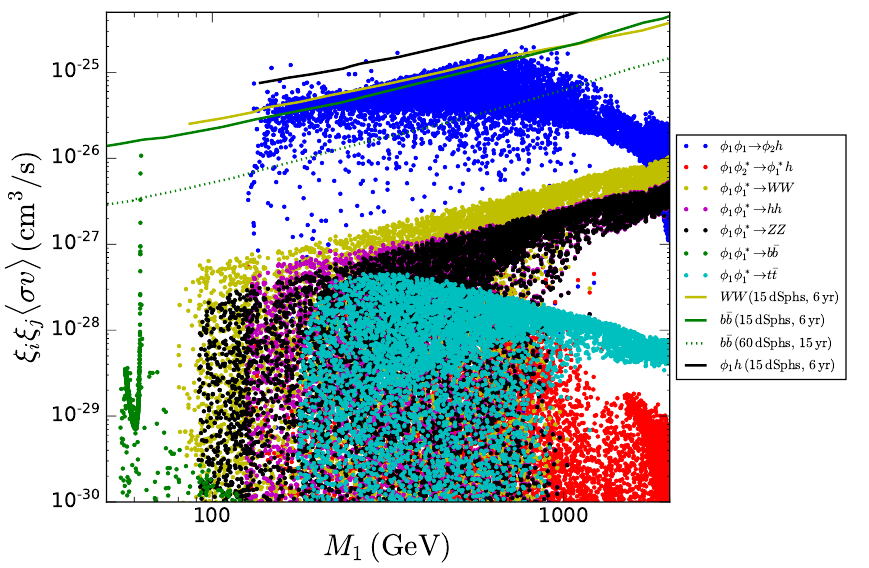
Figure 12 . Dark matter annihilation rates for the viable models in the scan with (cid:22) S 1 6 = 0. The solid-green (solid-yellow) line shows current limit of (cid:30) 1 self-annihilation into b (cid:22) b ( W + W (cid:0) ) reported by the Fermi collaboration from 6 years of observation and 15 dwarf spheroidal galaxies (dSphs) [28], while the dotted-green line represents the projected sensitivity for 45 dSphs and 15 years of observation [29] which serves as an estimate of the corresponding W + W (cid:0) sensitivity since both bounds for 6 years as 15 dSphs are similar at high DM masses. Moreover, for comparison purposes the upper limit on the semi-annihilation process (cid:30) 1 (cid:30) (cid:3) ! (cid:30) 1 h [36] is also 1